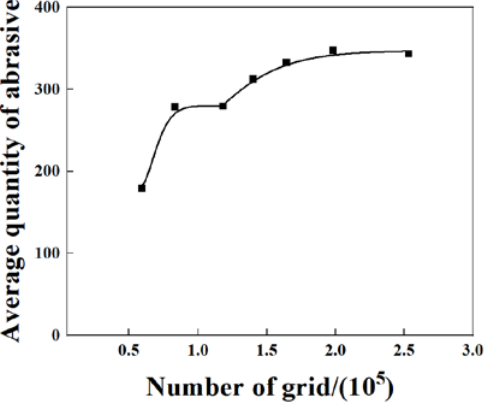
Figure 5. The effect of grid number on the number of abrasives.